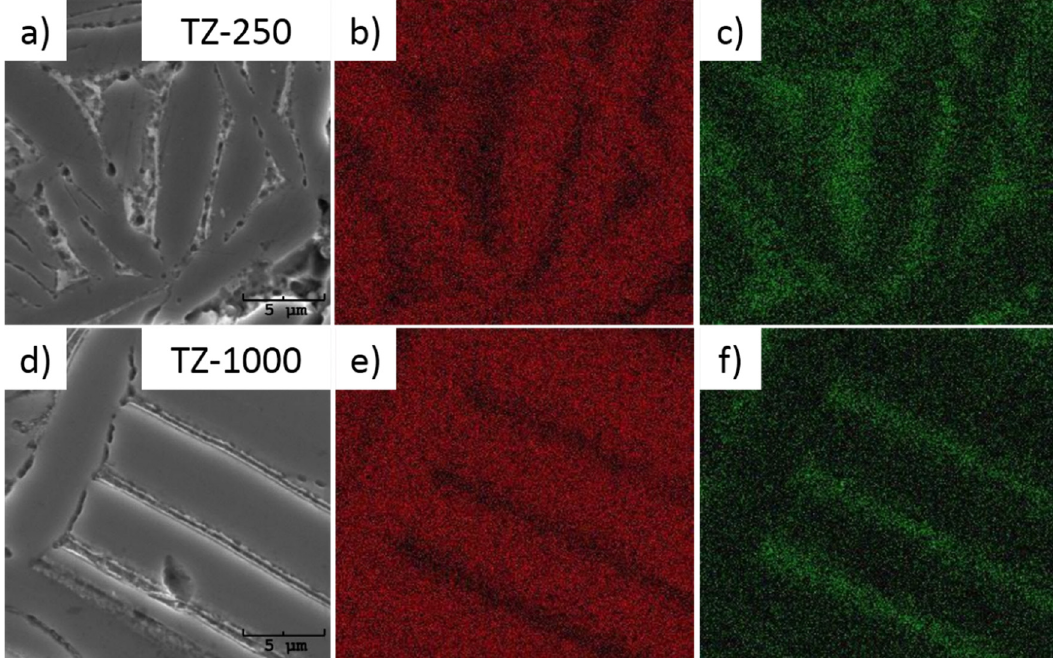
Figure 5. Distribution maps of the elements for the sample under isostatic pressure of 250 MPa (SEM micrograph ( a ), Ti ( b ) and Zr ( c )) and 1000 MPa (SEM micrograph ( d ), Ti ( e ) and Zr ( f )).